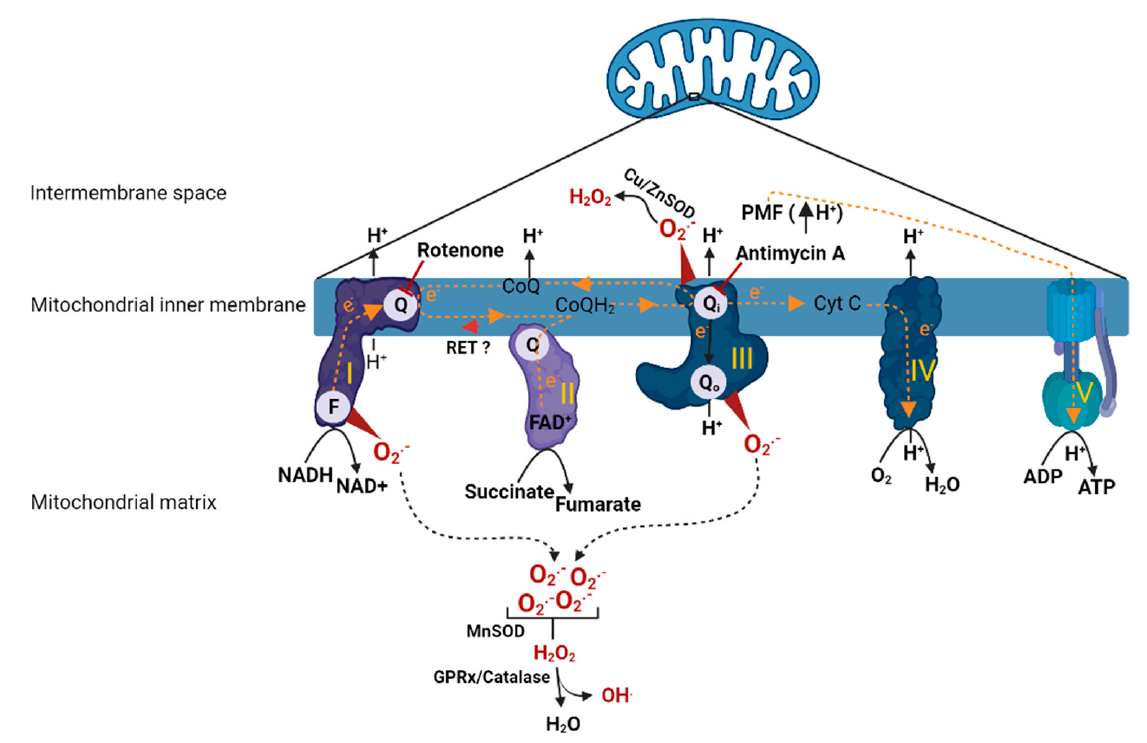
Figure 1. Animation depicting oxidative phosphorylation and ROS production in mitochondria. Once electrons have entered into the ETC, a series of redox reactions facilitate electron transfer within the ETC. Electron transfer leads to translocation protons from matrix to inner membrane space causing development of PMF, which drives Complex V to carry out phosphorylation of ADP. Direction of electron transfer or proton translocation are denoted with arrows. Complex I (FMN (or F) and quinone (or Q) binding sites) and Complex III (quinone (or Q) binding site) are the major sites of ROS production in the mitochondria. A concise depiction of ROS metabolism is also shown. Rotenone (Complex I inhibitor) and antimycin A (Complex III inhibitor) sites of action are indicated with inhibitory symbols. Reverse electron transfer from Complex II to Complex I is indicated with red arrowhead. ETC complexes are indicated by roman numerals. H + ; proton, CoQ/CoQH 2 ; coenzyme Q (oxidized/reduced), Cu/Zn SOD; copper/zinc superoxide dismutase, Cyt C; cytochrome C, e − ; electron, F; FMN binding site, FAD + ; flavin adenine dinucleotide (oxidized), FMN; flavin mononucleotide, GPRx; glutathione peroxidase, H 2 O; water, H 2 O 2 ; hydrogen peroxide, MnSOD; manganese superoxide dismutase, NADH/NAD + ; nicotinamide adenine dinucleotide (reduced/oxidized), O 2 ; molecular oxygen, O 2 •− ; superoxide, PMF; proton motive force, Q/Qi/Qo; CoQ binding sites, RET; reverse electron transfer. The figure was created using BioRender.